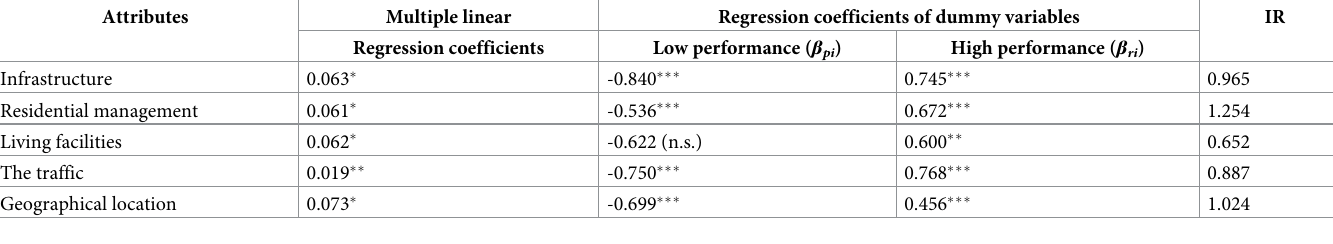
Table 6. Asymmetric impact of attributes’ performance.